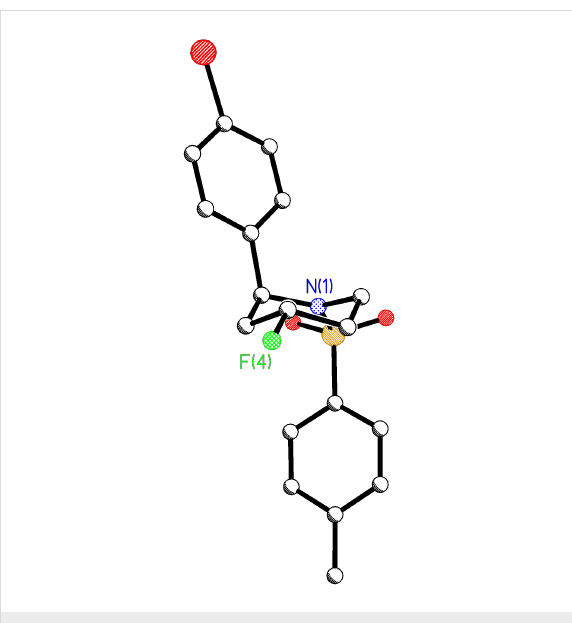
Figure 3: X-ray crystal structure of the minor anti -piperidine product 14d